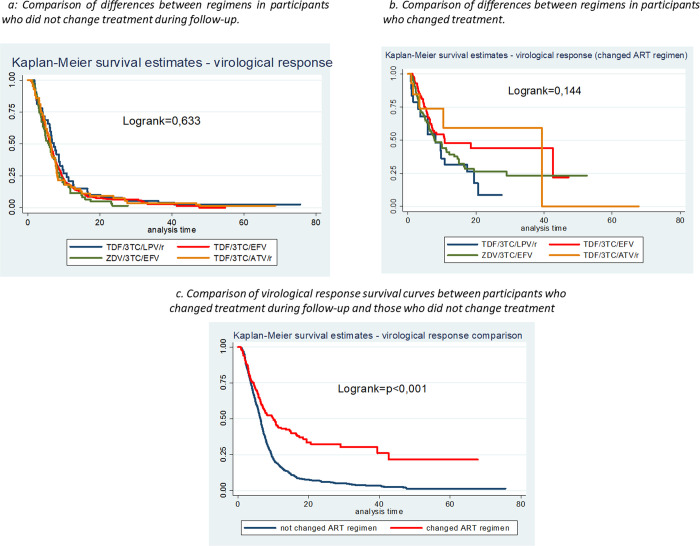
Survival curves for virologic response by regimen, considering regimen change.